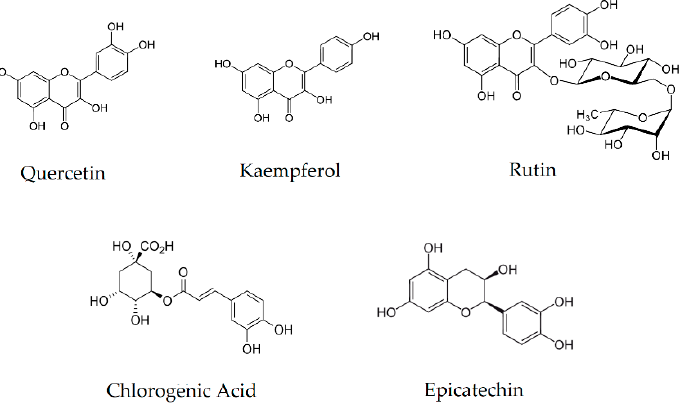
Figure 1. Chemical structures of the five compounds determined in the raw material. Table 1. Quantitative analysis of the content of active compounds in the tested Actinidia